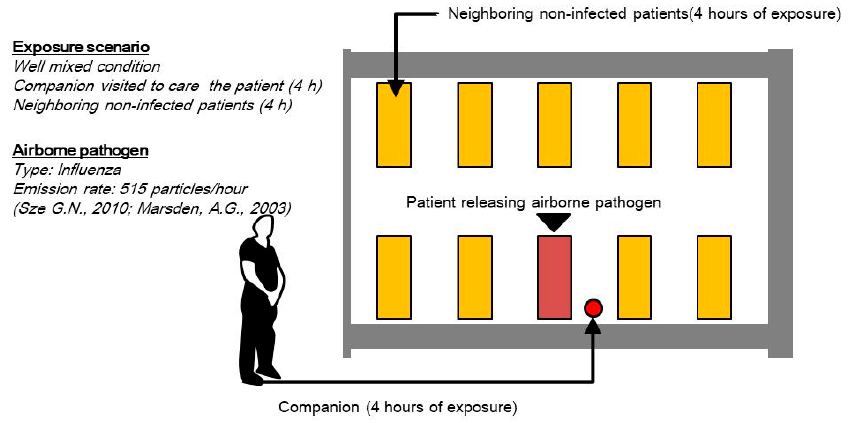
Figure 5. Quanta generation scenario.